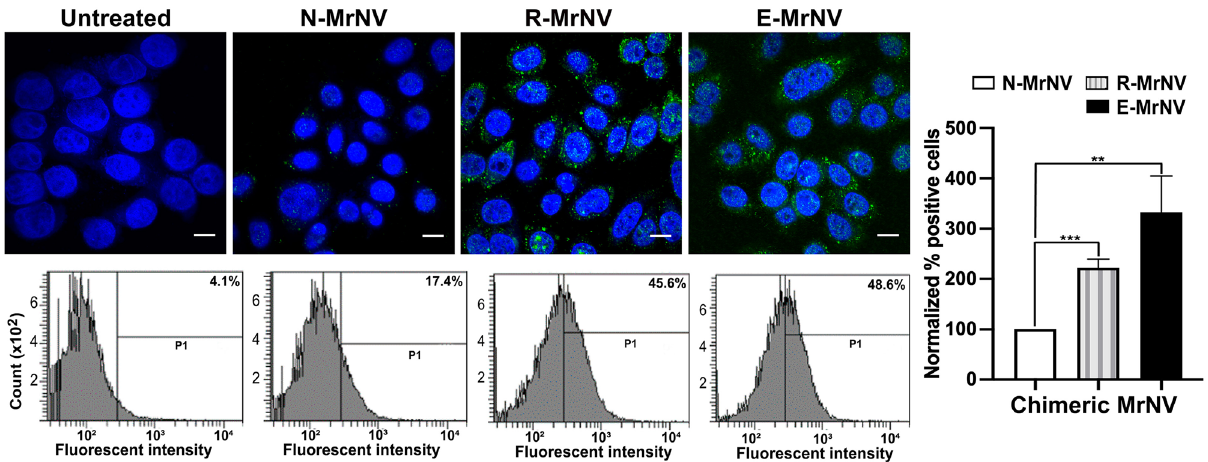
Figure 5. Internalization of chimeric MrNV-VLPs to SW480 cells. SW480 cells were processed similarly as binding assay with all types of MrNV-VLPs followed by an additional 30 min incubation after cell washing and further analyzed with confocal microscopy (upper row, bars = 10 μm) and flow cytometry (lower row). The normalized percent positive cells and their statistical analysis were shown in the right-most panels (mean ± SEM, n = 3, * p < 0.05, Student’s t